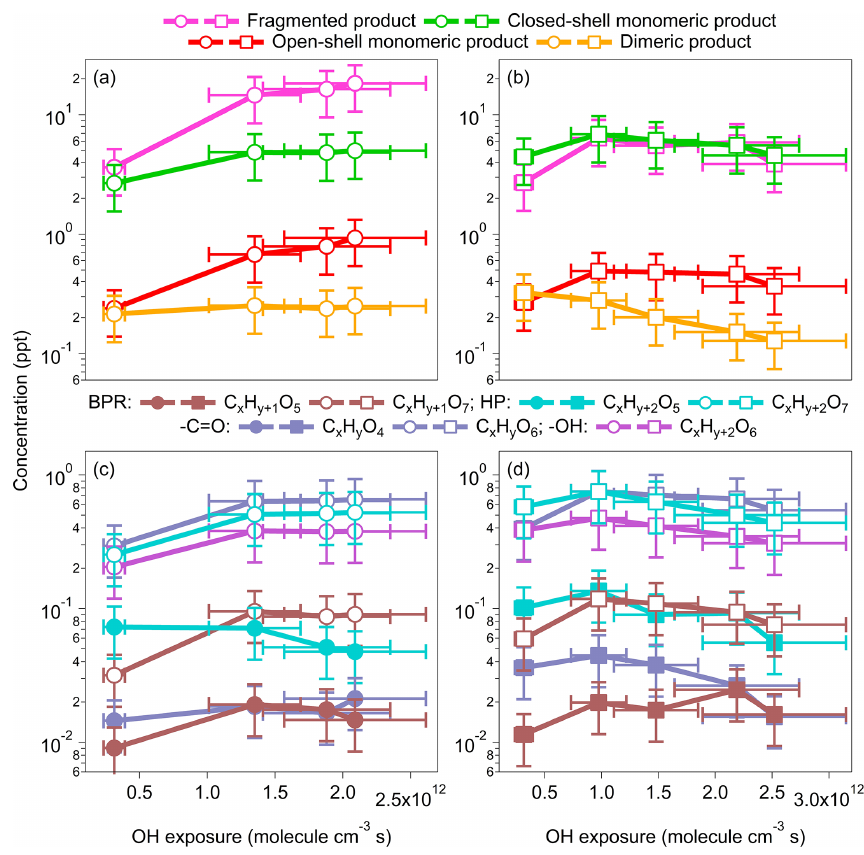
Figure 2. Concentrations of fragmented, monomeric closed-shell, open-shell, and dimeric products formed by benzene and toluene oxidation under low-NO x conditions (OFR254-5) at various OH exposures. For the benzene oxidation, both x and y are 6. For the toluene oxidation, x is 7, and y is 8. Note: BPR – bicyclic peroxy radical; HP – hydroperoxide; − C=O – carbonyl; − OH –